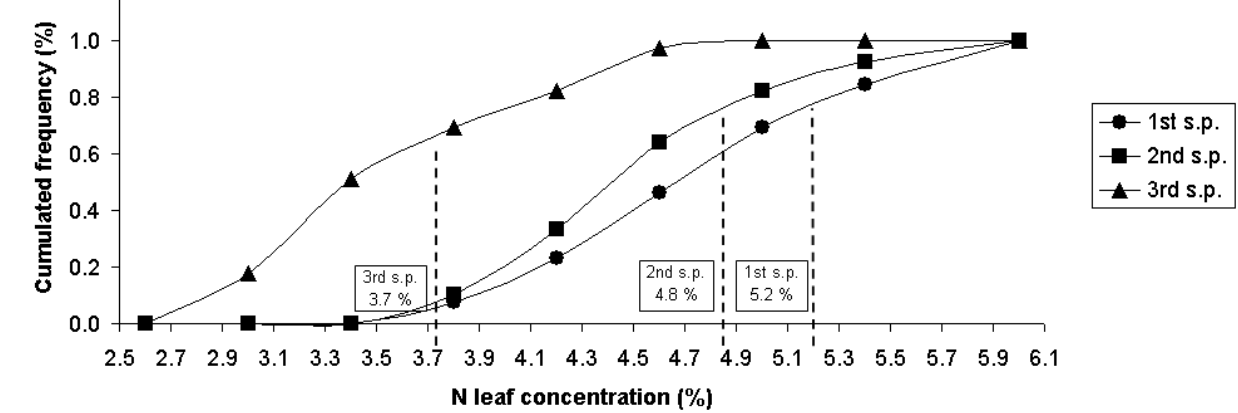
Figure 2. Cumulated nitrogen concentration frequency chemically measured in relation to the three different sampling periods (s.p. 1st, 2nd and 3rd) and the three thresholds (vertical lines) extracted by the critical-N curve proposed by Tei et al.